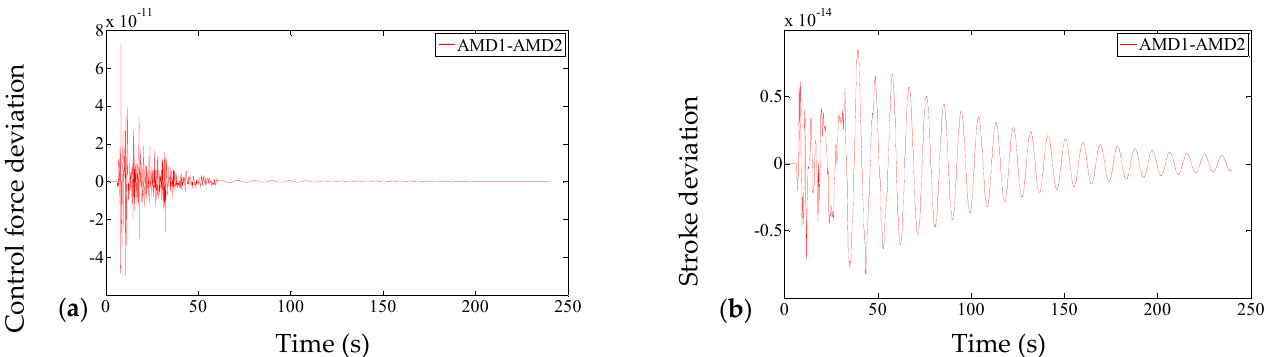
Figure 3. The AMD parameters of the systems without time delays, ( a ) the forces of System1, ( b ) the total forces of System2, ( c ) the strokes of System1, ( d ) the strokes to AMD1 of System2.